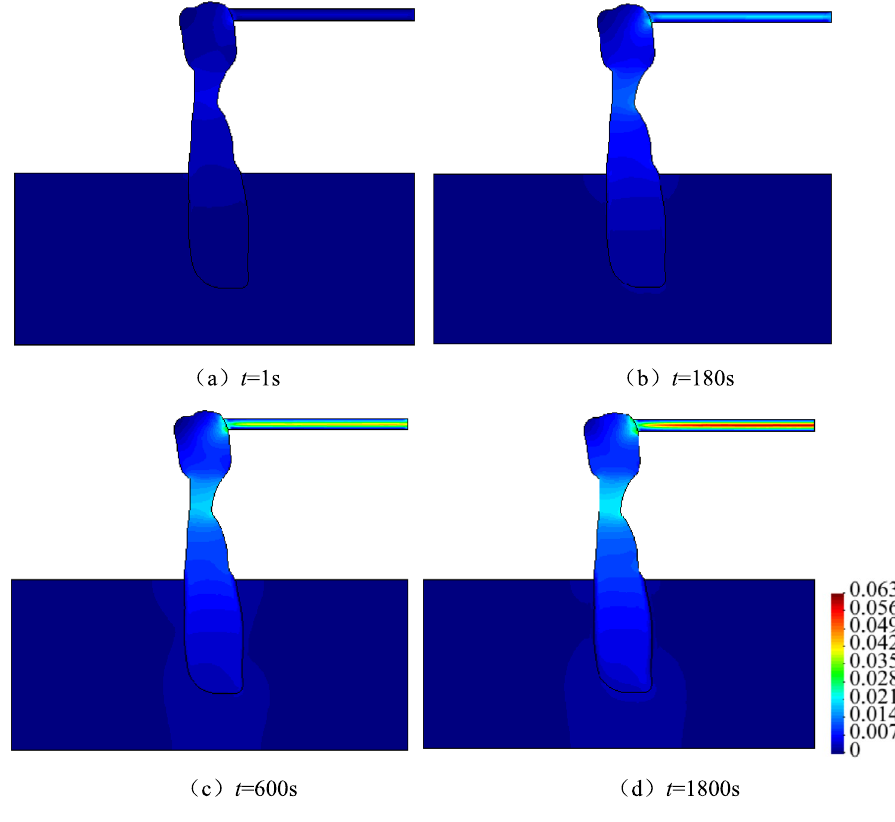
Figure 9. Space–time evolution process of velocity (unit: m/s).